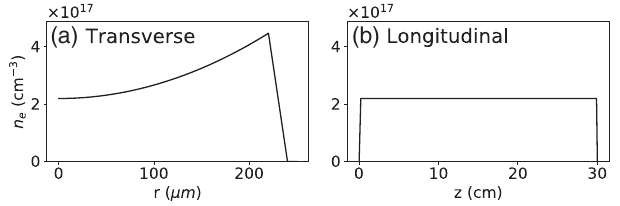
FIG. 1. (a) Transverse and (b) longitudinal profiles for the 30-cm-long capillary. The longitudinal profile is given on